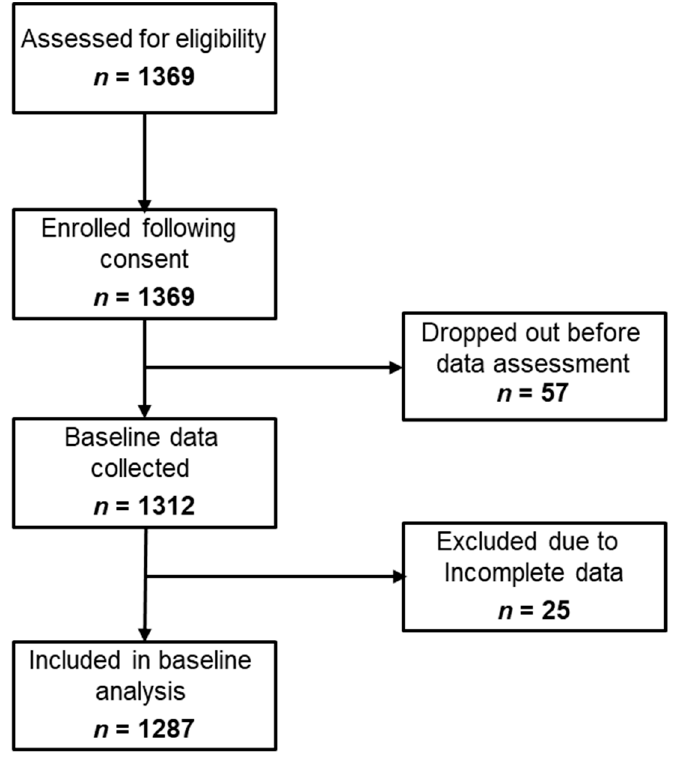
Figure 1. STROBE-nut flow diagram of children in the South African arm of the KaziAfya project included in the analysis.